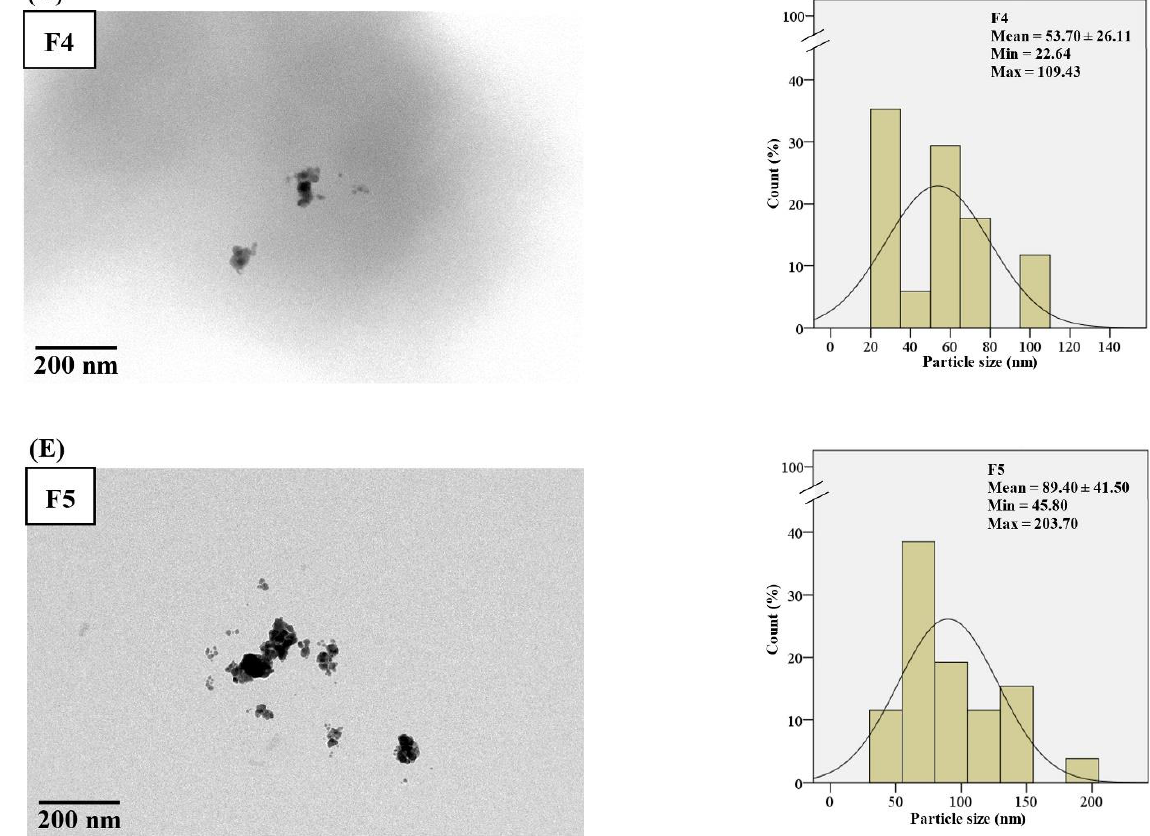
Figure 2. TEM micrograph and histogram of the particle size distribution of nanoparticles. ( A ) AgNPs in F0, and ( B – E ) Col-AgNPs in F2–F5. The electron microscope was operated at 200 kV, and the images were captured at the magnification of 40,000× . A scale bar of 200 nm was provided .